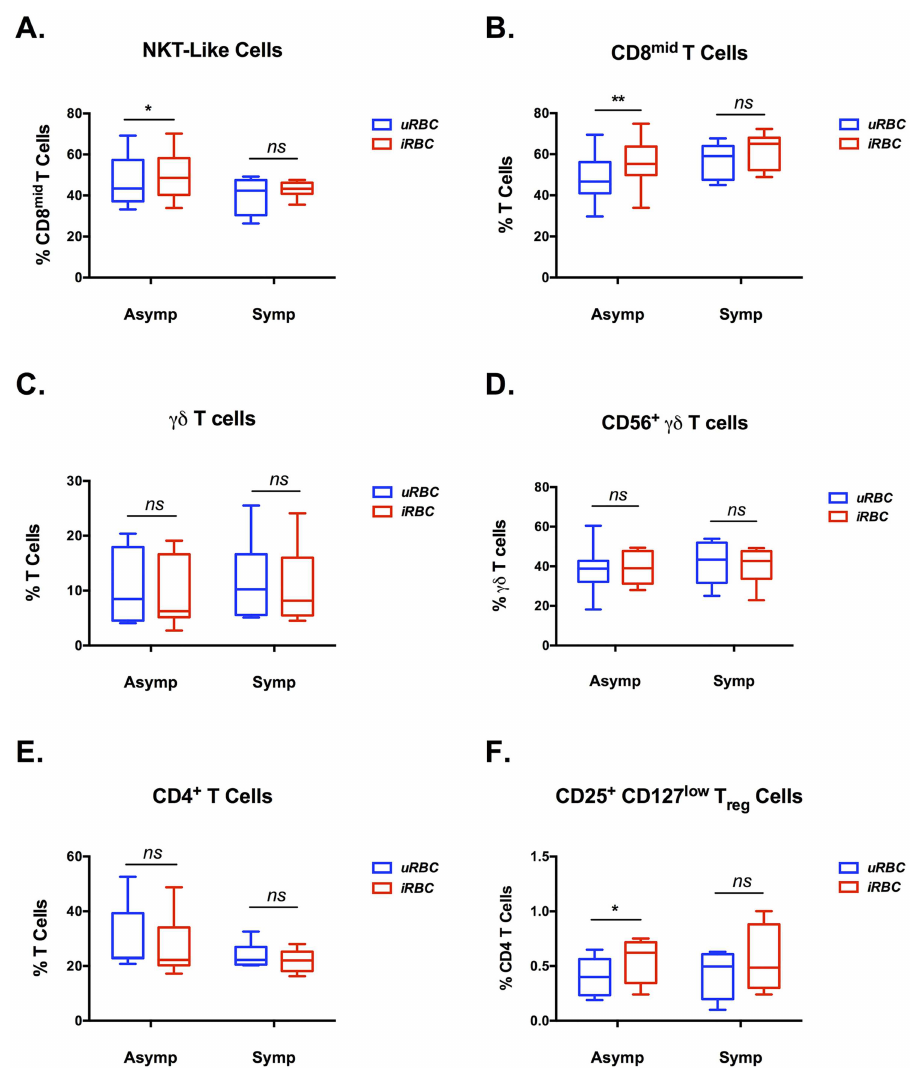
Fig 4. P. falciparum responsive T cell subtypes identify asymptomatic malaria patients. PBMCs from malaria patients were co-culturedfor 6 days with lysate from uRBC or P . falciparum schizonts (iRBC lysate) at a lymphocyte to parasiteratio of 1:2. Changesin the percentages of T cell subpopulations duringculture were comparedbetweenasymptomatic (n = 9, Asymp) and symptomatic (n = 6, Symp) patients in (A) NKT-like T cells, (B) CD8 mid T cells, (C) γδ T cells, (D) CD56 + γδ T cells, (E) CD4 + T cells, and (F) CD25 + CD127 low T regulatorycells. Data are representedas box and whisker plots, with box ends extendingfrom the first to the third quartileand the medianin the center. Whiskers extend to the highestand lowest data point. Statistical significancewas determined using a two-tailedWilcoxon matched-pairs signedrank test (iRBC lysate vs. uRBC for each patient). * = p-value < 0.05, ** = p-value < 0.01.